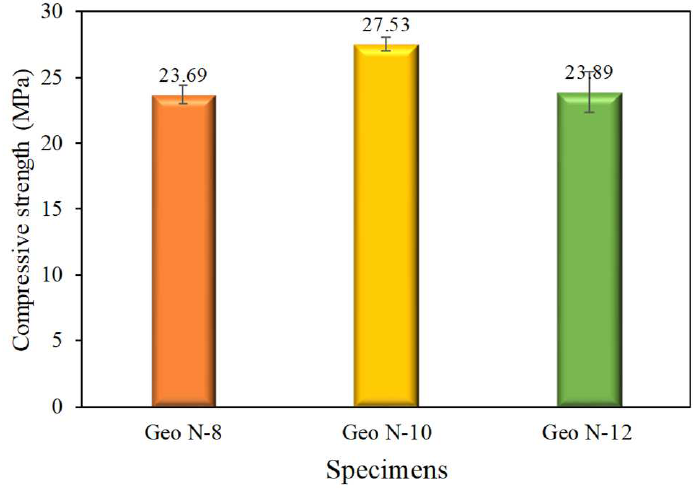
Figure 6. The compressive strength of geopolymer paste .